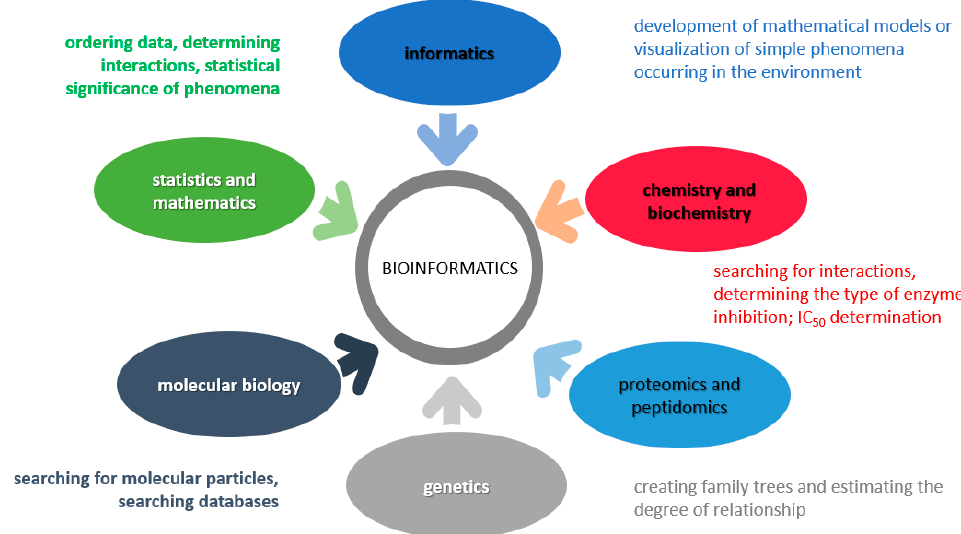
Figure 1. Application of bioinformatics in the field of science.